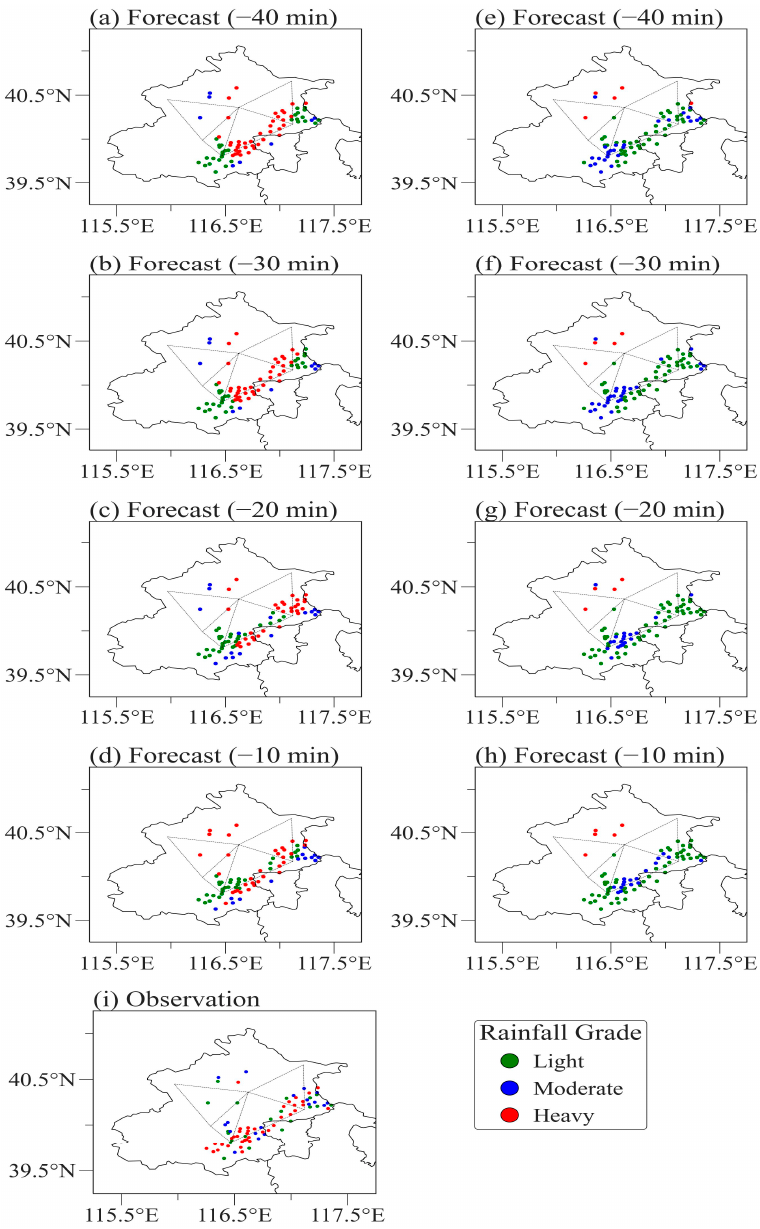
Figure 13. The same as Figure 10 but for the grade forecast of the rainfall initiated at 12:10 BJT on 12 August 2018, where panels ( a – d ) are based on the features of divergence, vorticity, and vertical velocity from the RWP measurements (the binary RWP model) and panels ( e – h ) are from the ERA-5 reanalysis data (the binary ERA-5 model). The panels ( i ) is the rainfall observation record at 12:10 BJT. The green, blue, and red dots represent the rain gauge stations with light, moderate, and heavy rain forecast, respectively. Table 5. The same as Table 4, but for the grade forecast of the rainfall case that occurred at 12:10 BJT on 12 August 2018. Metrics Grades